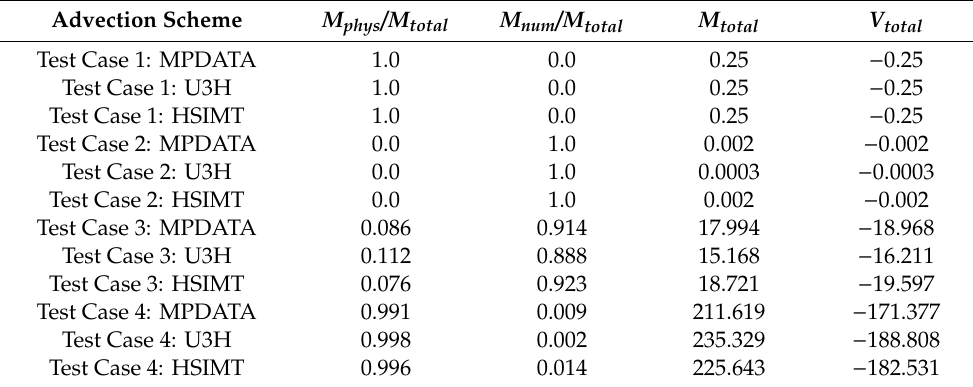
Table 1. Comparing physical, numerical mixing with total mixing and variance decay. Column 1: M phys / M total = Ratio of physical to total mixing; Column 2: M num / M total = Ratio of numerical to total mixing; Column 3: M total = Total mixing (non-dimensionalized by total volume) in ( ◦ C) 2 for test case 1 and in (psu) 2 for test cases 2, 3, 4. Column 4: V total = Total variance decay (non-dimensionalized